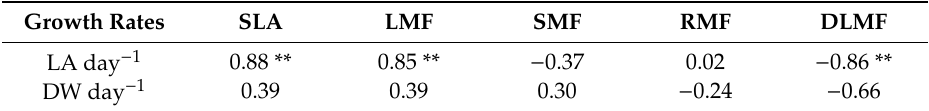
Table 5. Pearson correlation coe ffi cients for correlations between leaf area (LA) and dry weight (DW) increases per day between 35 and 49 day after sowing and SLA and organ mass fractions, respectively, including mean values all treatments ( n = 9) with the same daily mean temperature. Growth Rates SLA LMF SMF